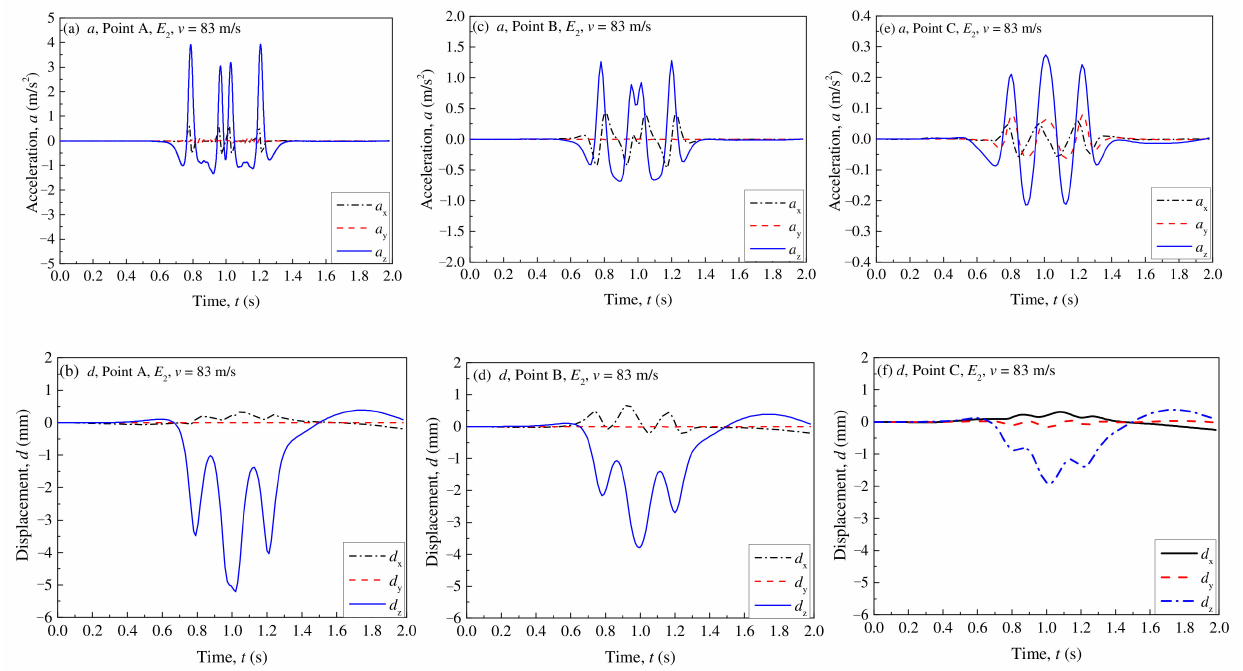
Figure 6. Changes in the acceleration and displacement with time at different points: ( a ) a, Point A; ( b ) a, Point B; ( c ) a, Point C; ( d ) d, Point A; ( e ) d, Point B; ( f ) d, Point C.